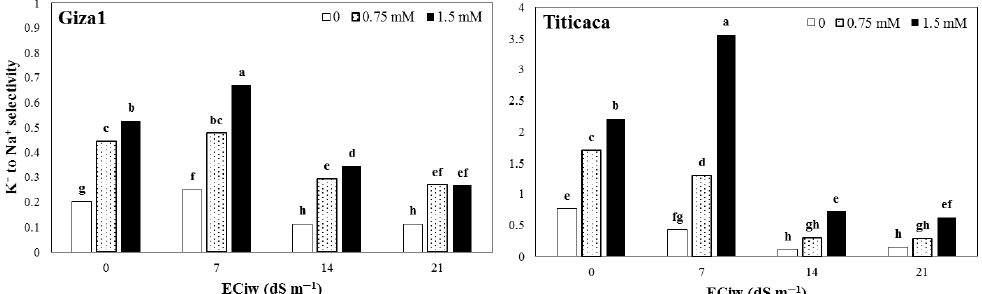
Figure 3. The K + to Na + selectivity of two quinoa cultivars treated by varied salicylic acid concentra- tions grown under different salinity of irrigation water (ECiw). The columns with at least a similar letter in each figure are not significantly different based on LSD at 1% probability level. In general, SF was lower in salt-stressed plants so that the lowest NaSF, KSF, and MgSF were obtained in non-saline treatments, and ClSF and CaSF were also low in non- saline conditions (Table 3). The highest values of NaSF, KSF, ClSF, CaSF, and MgSF were obtained at salinity levels of 7, 21, 21, 7, and 21 m − 1 , respectively. Interestingly, the effects of SA on the SF of different ions were not similar. SA-treated plants had higher NaSF, ClSF, and MgSF and lower KSF and CaSF. The SF responses of different ions to salinity, and especially SA, were almost similar in the two quinoa cultivars, but their values were varied. Titicaca cultivar had higher NaSF and ClSF, while KSF, CaSF, and MgSF were higher in Giza1 cultivar (Table 3). Table 3. The storage factor of ions in quinoa plants treated with varied salicylic acid (SA) concentrations grown under different salinity levels. Cultivar